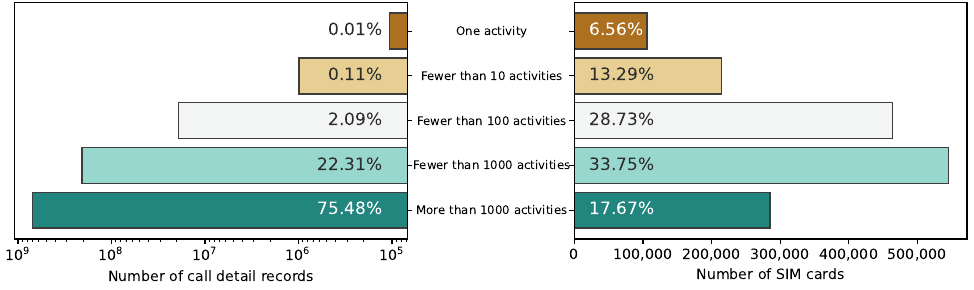
Figure 2. The SIM cards in the “April 2017” data set categorized by the number of CDRs. The left figure shows the number of CDRs and the right figure shows the number of SIM cards in each category. The SIM cards over a thousand records (17.7%) provide the majority (75.48%) of the activity.